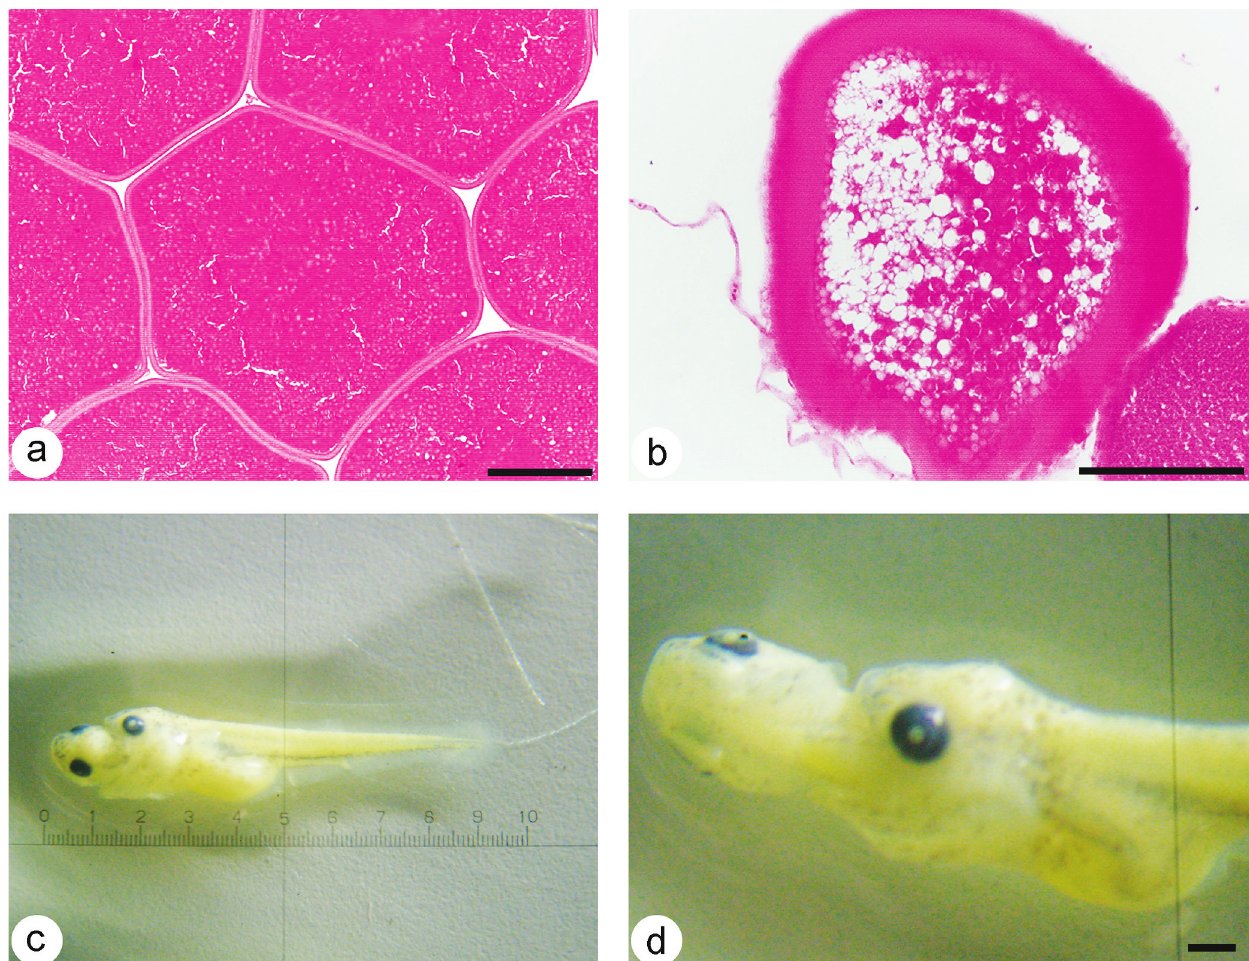
Fig. 2. Microscopic aspect of the ovaries and macroscopic aspect of Salminus hilarii larvae: a. micrograph of a mature ovary, showing the vitellogenic oocytes; b. micrograph of the ovary showing an atretic oocyte. Scale bars: ( a ) 300  m and ( b ) 100  m; c. cannibalism among S . hilarii larvae; d. details of the larva head at the cannibalism moment (Scale bars = 1